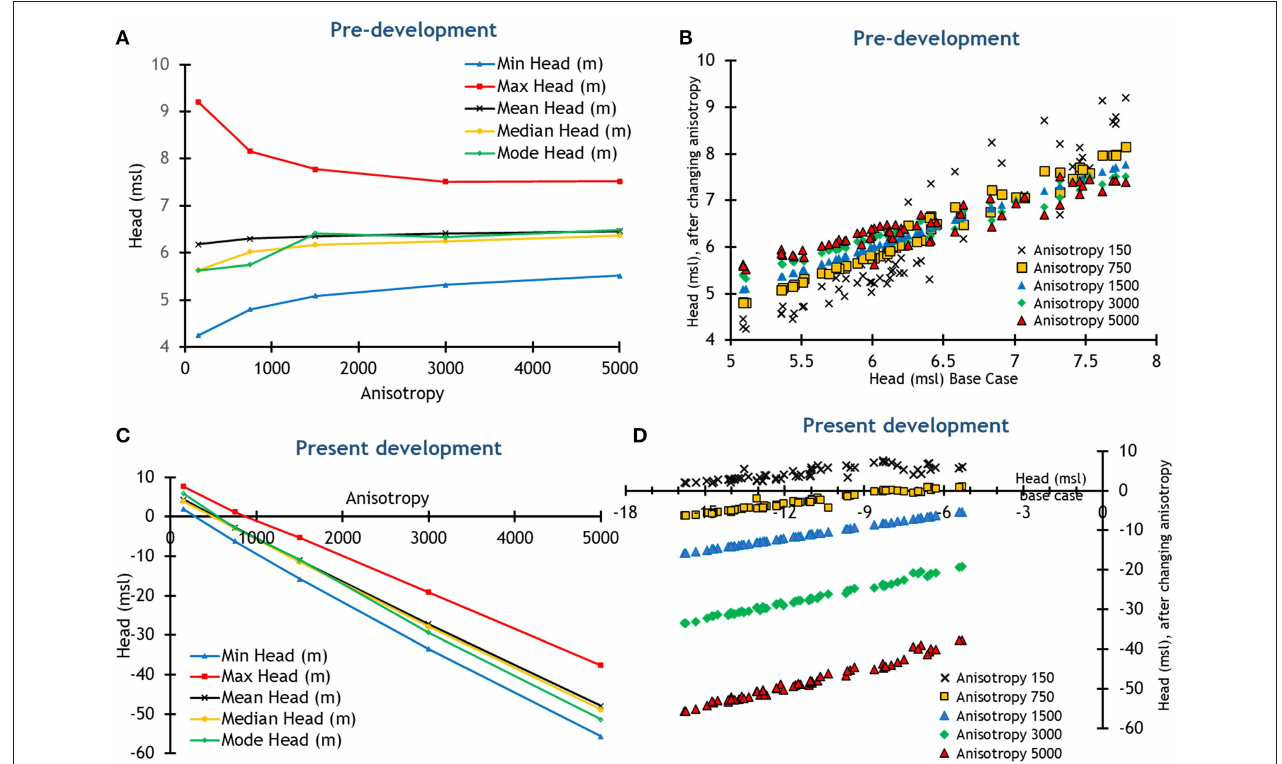
FIGURE 4 | (A) Change of predictive head with respect to anisotropy under predevelopment conditions. (B) Change of predictive head under different anisotropy with respect to base-case head under predevelopment conditions. (C) Change of predictive head with respect to anisotropy under present development conditions. (D) Change of predictive head under different anisotropy with respect to base-case head under present development conditions.